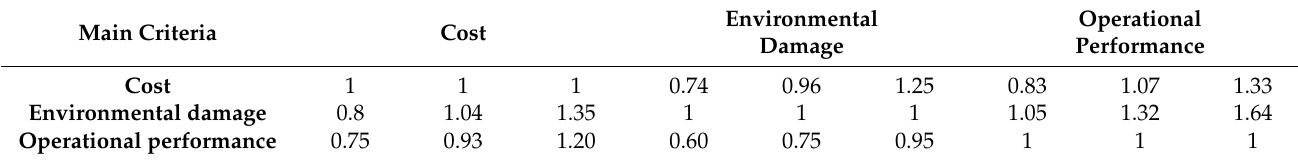
Table 4. Pairwise comparison matrix for main criteria (CR= 0.019).